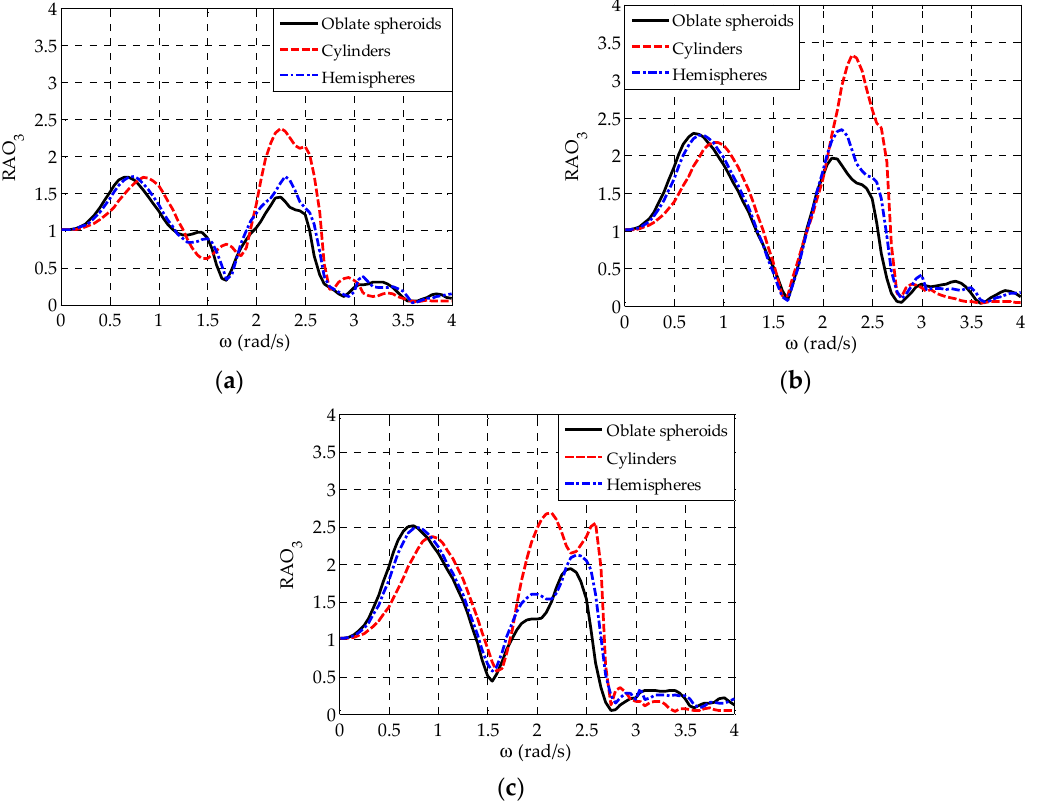
Figure 5. Comparison of RAO 3 for arrays with di ff erent WEC geometries and for l w / a = 18, c = 6 m, l bet / a = 4: ( a ) WEC1 and WEC5, ( b ) WEC2 and WEC4, and ( c ) WEC3.